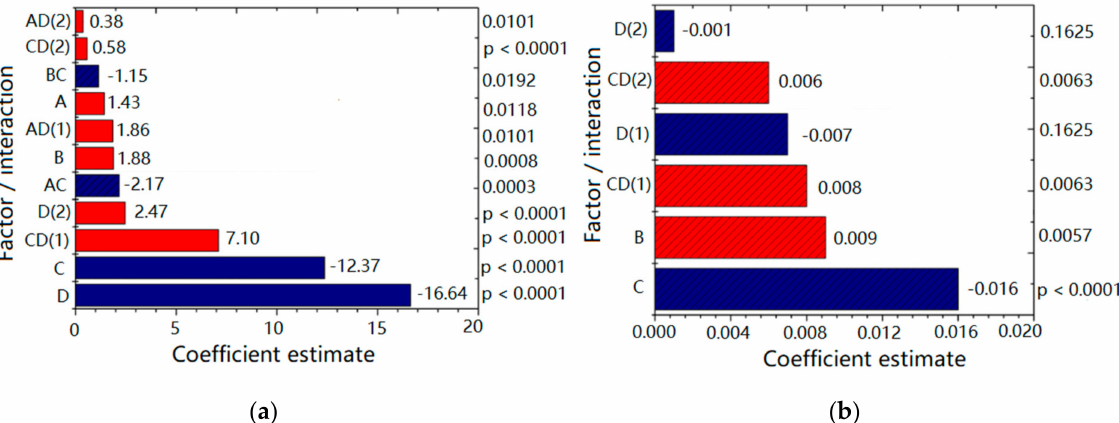
Figure 1. Plots for ( a ) mean droplet size—Z-Ave; ( b ) polydispersity index—PDI with the coefficient values and p values for the factors and their interactions. A: PEG-PL type; B: PEG-PL concentration; C: HPH pressure; D: number of HPH